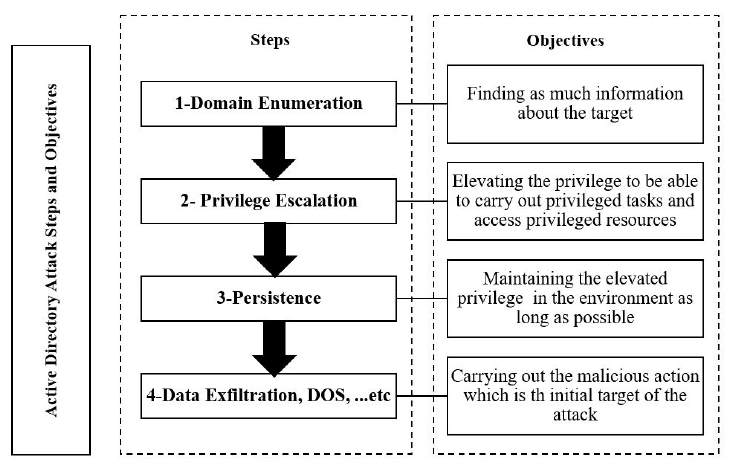
Figure 2. Active Directory attack